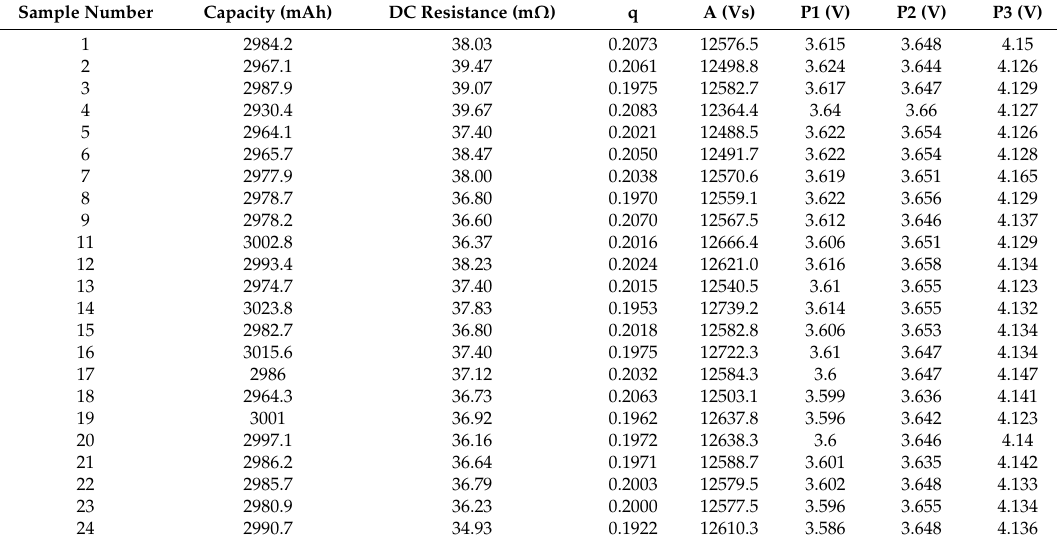
Table 4. Consistency features of cells sample before vibration test.